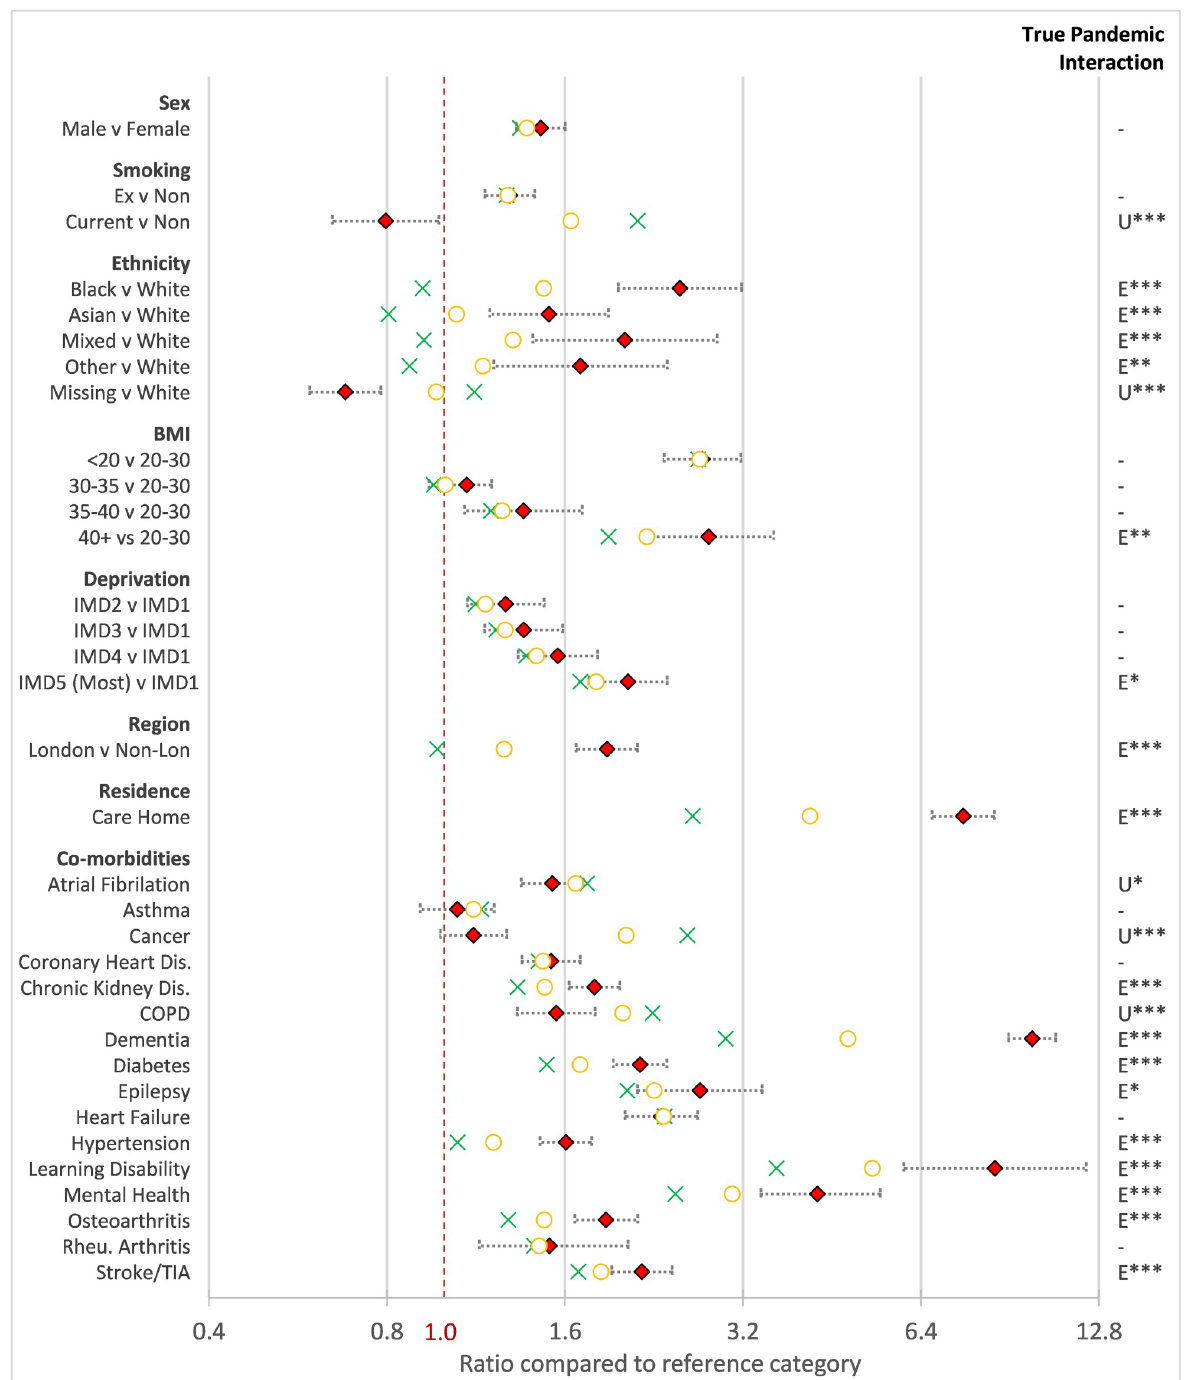
Fig 1. Mortality ratios for 2020 (amber) and usual (green) with corresponding excess mortality ratio and 95%CI (red). Green cross = Usual mortality ratio (2015–19), Amber circle = 2020 mortality ratio, Red Diamond = Excess mortality ratio. True Pandemic Interaction summaries statistical comparison between the Excess versus Usual mortality. E = Excess significantly higher, U = Usual significantly higher, � = p < 0.05, �� = p < 0.01, ��� = p < 0.001.